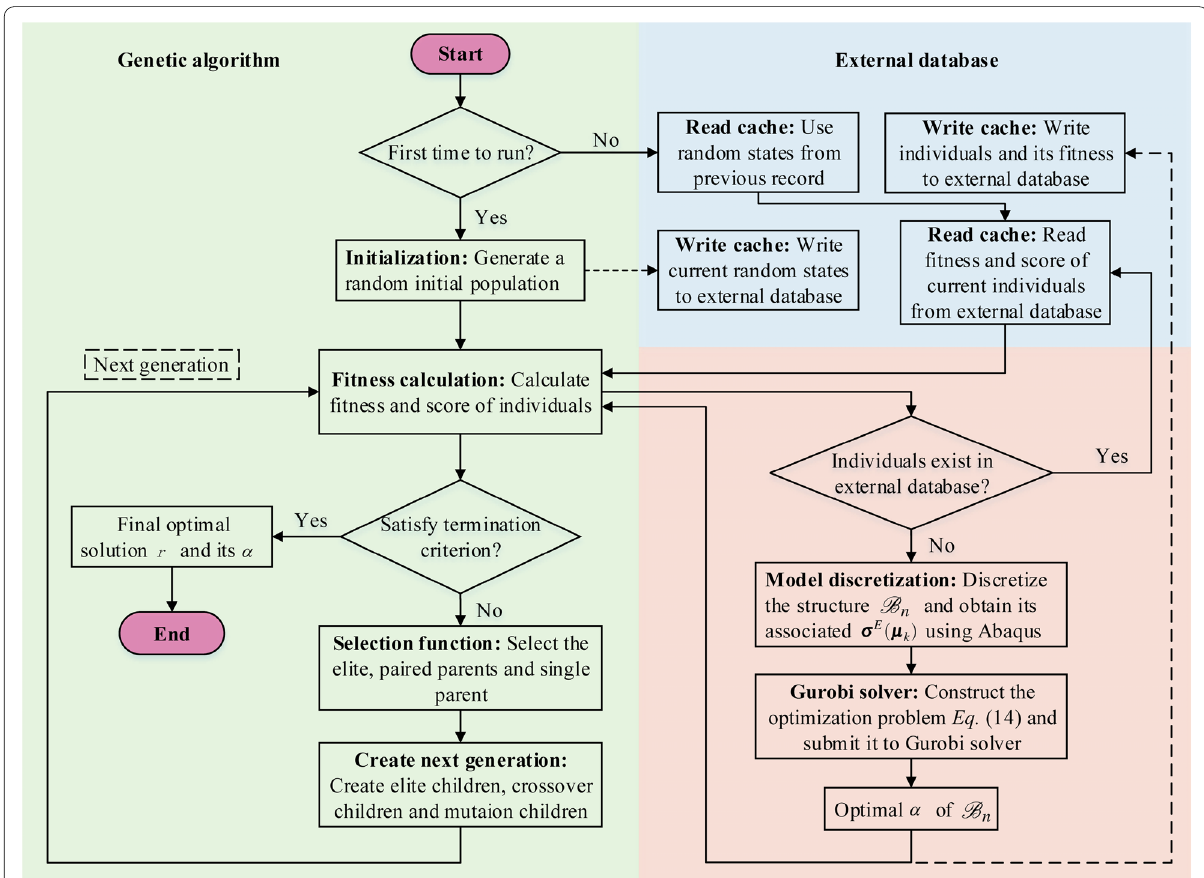
Figure 1 Flowchart of genetic-gradient coupling algorithm for structure optimization